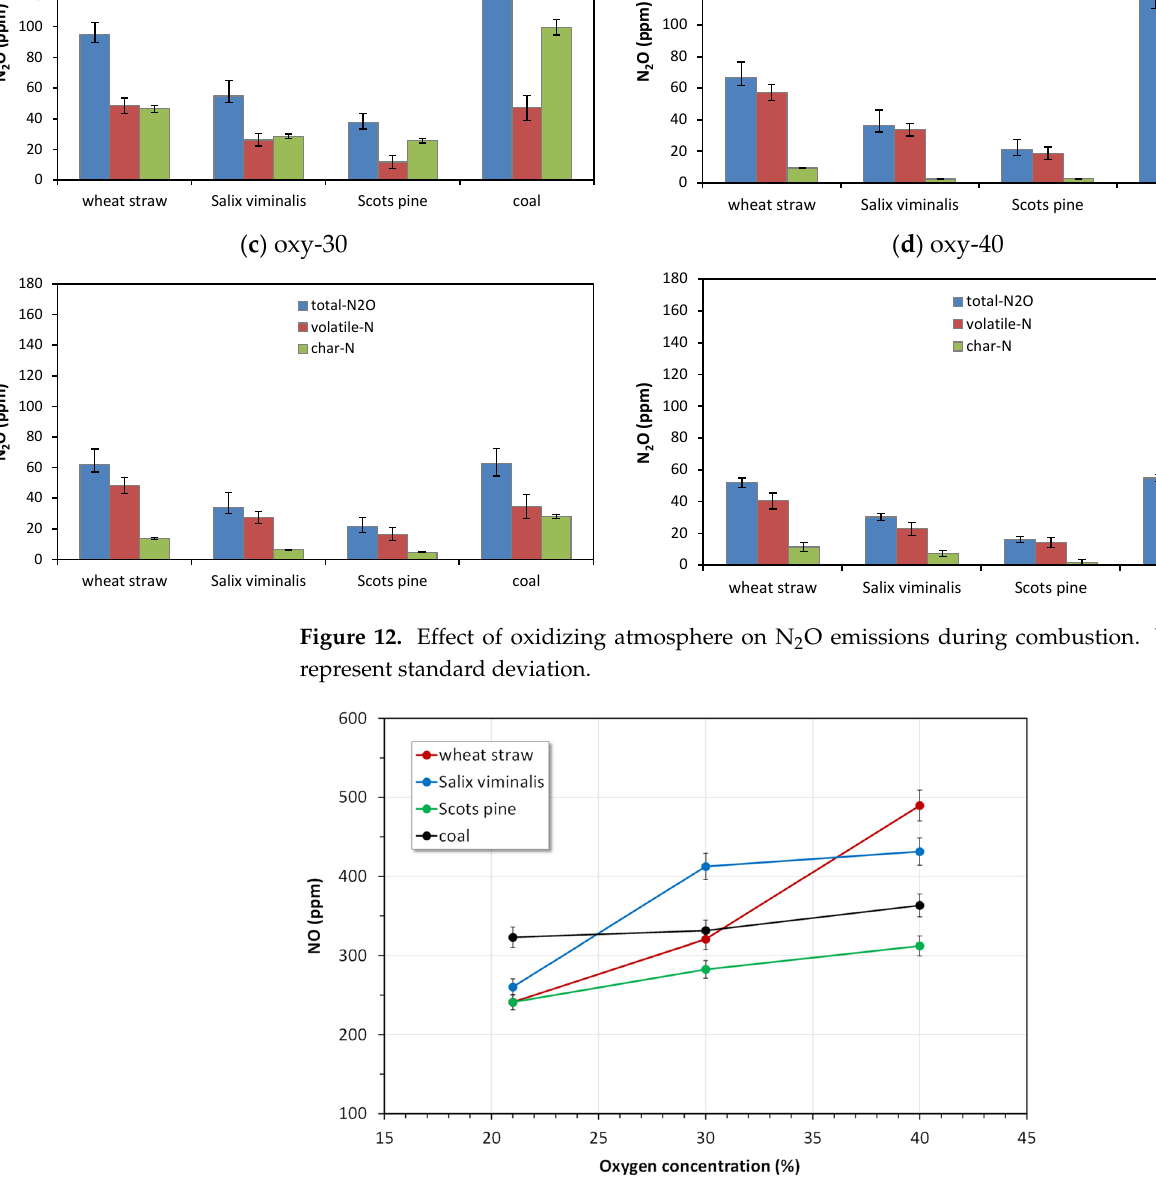
Figure 14. Effect of the oxygen concentration on the total emissions of N 2 O during oxy-combustion. Vertical bars represent standard deviation. Hydrogen cyanide is a main precursor of N 2 O formation. It should be mentioned that HCN is a very toxic gas (approximately 20 times more toxic than CO) that already affects human beings at ppm levels [31]. Higher concentrations of HCN were generated during oxy-fuel combustion. Emissions of HCN were the highest in oxy-21 atmosphere, particularly during char combustion. The highest instantaneous concentrations of HCN did not exceed 6 ppm both for biomass fuels and coal. Similar results were reported in our previous study [22] and by Lasek et al. [31]. The highest NH 3 emissions were observed during combustion in oxy-30 and oxy-21 atmospheres. However, the instantaneous concentrations of NH 3 were very low; they did not exceed 3 ppm for all fuels. High concentrations of CO 2 inhibited oxidation of HCN and NH 3 to NO x . 4.2.2. Emissions of SO 2 The SO 2 emissions during biomass fuels and coal combustion in various environments are shown in Figure 15. The instantaneous SO 2 concentrations during oxy- combustion of biomass were much lower than those for the combustion of reference coal.